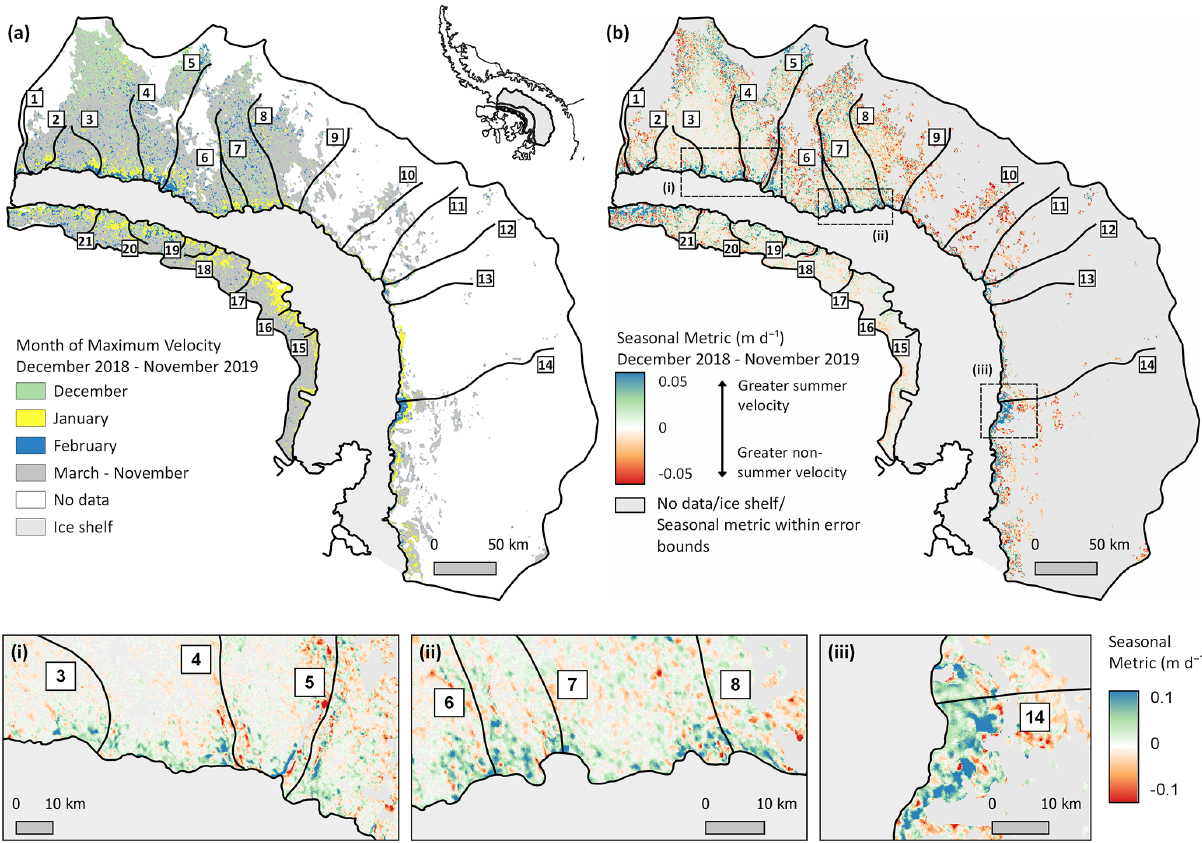
Figure 3. Spatially resolved patterns of seasonal ice flow as observed between December 2018 and November 2019. Panel (a) shows the month of maximum velocity ( v time ) and (b) the calculated velocity anomaly ( v anom summertime speed-up and negative (red) greater velocity during non-summertime months. Dashed boxes denote the location of the inset boxes (i–iii). See also Figs.